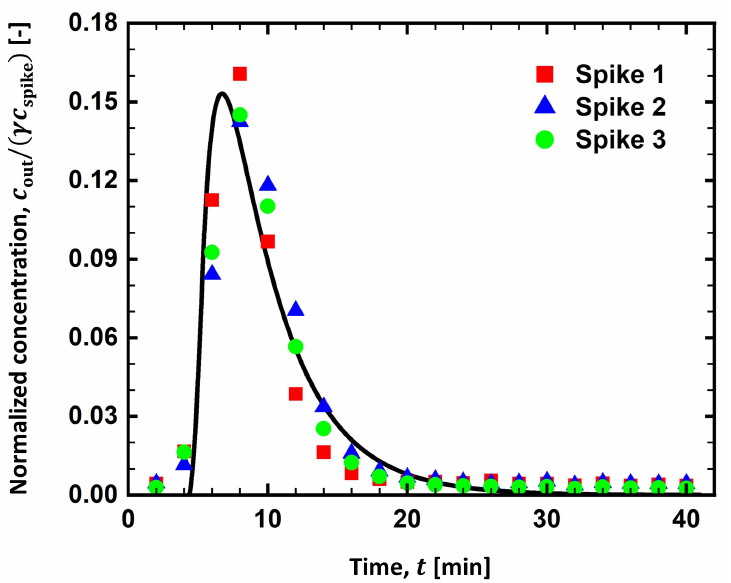
Figure 4. RTD curve from three repeated runs of the salt spiking experiments. The feed flow rate was 0.41 mL/min, and the spiking duration was 1 min at a flow rate of 0.041